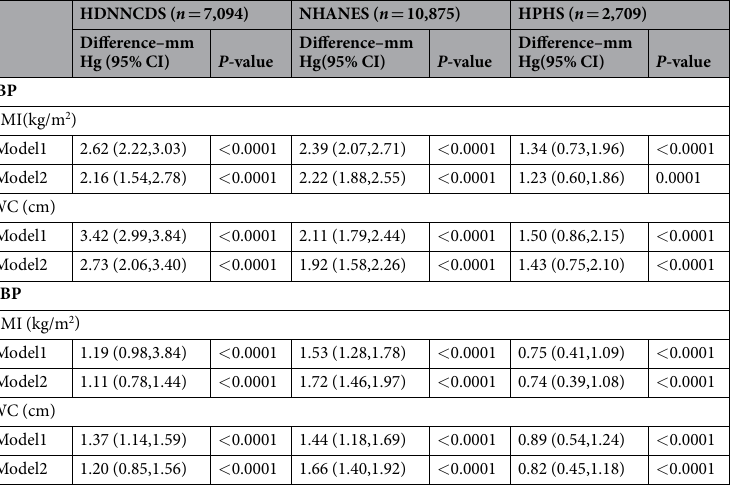
Table 2. Adjusted estimated differences in systolic or diastolic blood pressure associated with BMI or WC by 1 SD in the Harbin Cohort Study on Diet, Nutrition and Chronic Non-Communicable Diseases (HDNNCDS, 2012), the Harbin People’s Health Study (HPHS, 2008–2012), and the US National Health and Nutrition Examination Survey (NHANES). Abbreviation: BMI, body mass index; WC, waist circumference; SBP, systolic blood pressure; DBP, diastolic blood pressure. Model1: adjusted for age and sex. Model2: adjusted for age, sex, current smoking, current drinking, exercise regularly, type 2 diabetes, cardiovascular disease, family history of hypertension, and total energy intake in the HPHS and HDNNCDS; Adjusted for age, sex, ethnicity, exercise regularly, current smoking, current drinking, type 2 diabetes, cardiovascular disease, and total energy intake in the